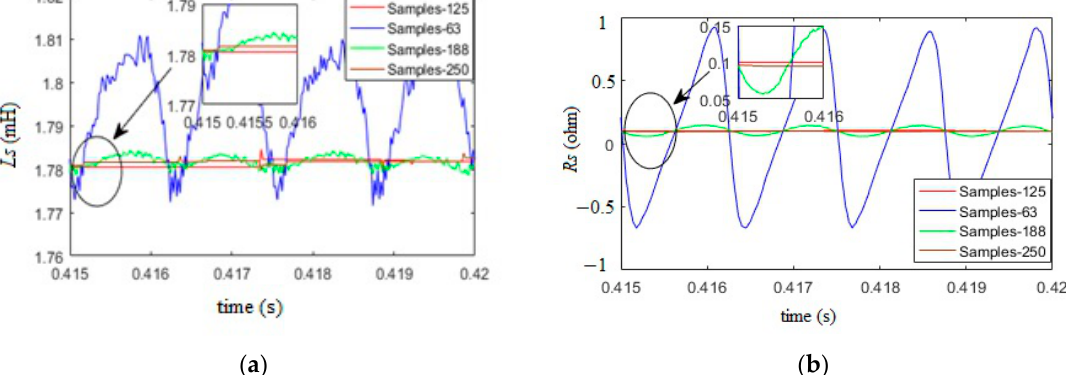
Figure 10. The estimated value of and in different samples with Bayesian estimation method ( L s = 2 mH, R s = 0.1 Ω ) ( a ) Estimated value of L s ; ( b ) Estimated value of R s